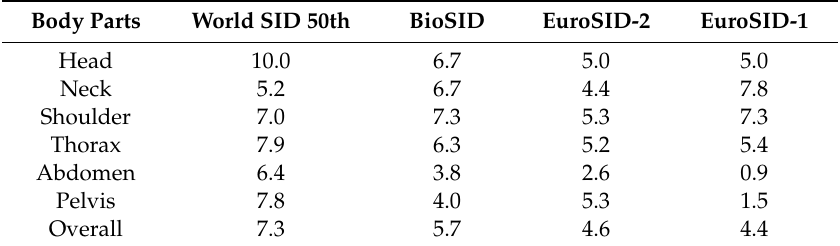
Table 1. Bio-fidelity comparison of side impact dummies [18,24,25].